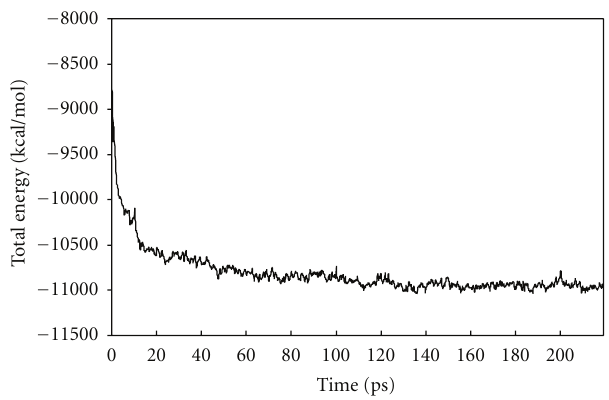
Figure 2: Molecular energy change of BLT1 through MD simula- tions.